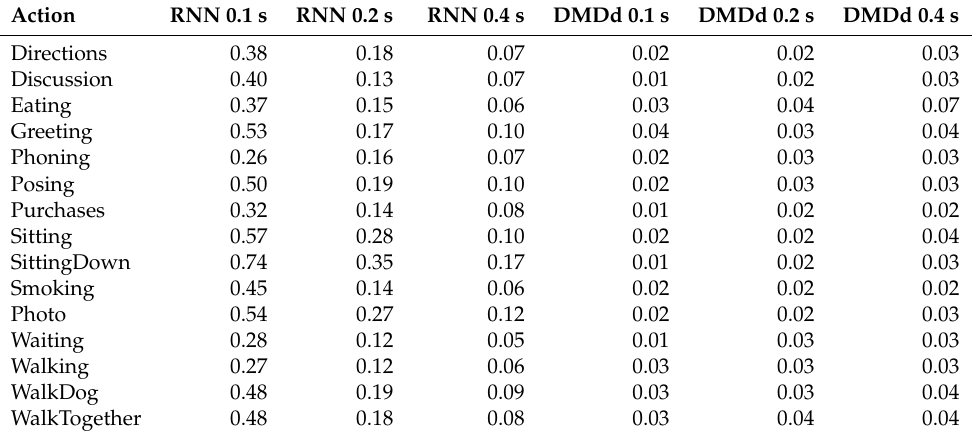
Table 2. Comparison of anticipation error using a RNN and Dynamic Mode Decomposition with 80 delays for various anticipation times. The error measure is the Kullback-Leibler divergence for anticipation times of 0.1s (5 frames), 0.2s (10 frames), and 0.4s (20 frames) on the different motion classes of the Human 3.6M dataset for actor